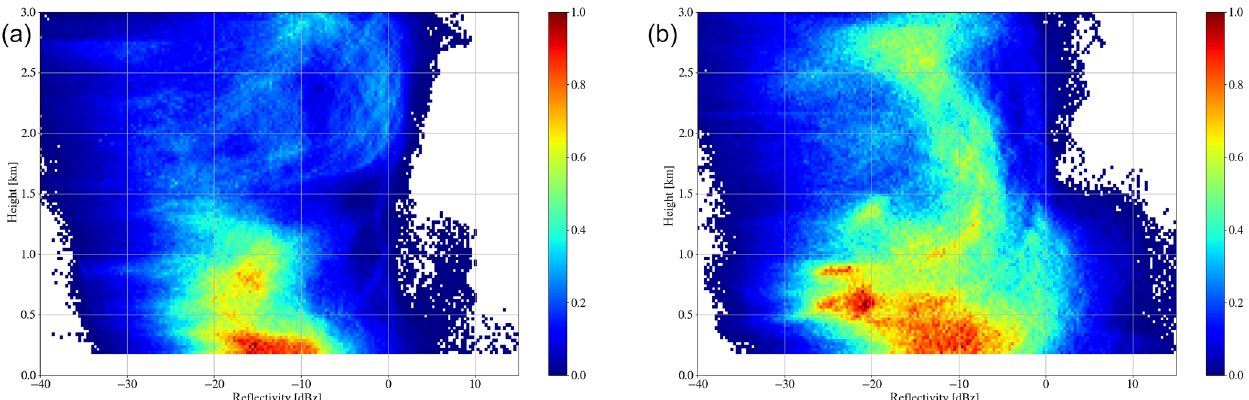
Figure 10. Contour frequency by altitude diagrams (CFADs) of sea ice (a) and ocean (b) . The frequency is normalized by the highest number within the CFADs for each case, respectively. A sea ice fraction of > 15% is used